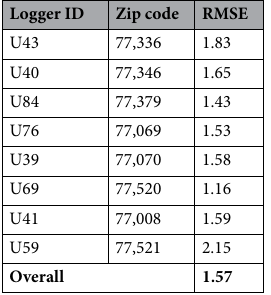
Table 4. Prediction performance for different loggers.